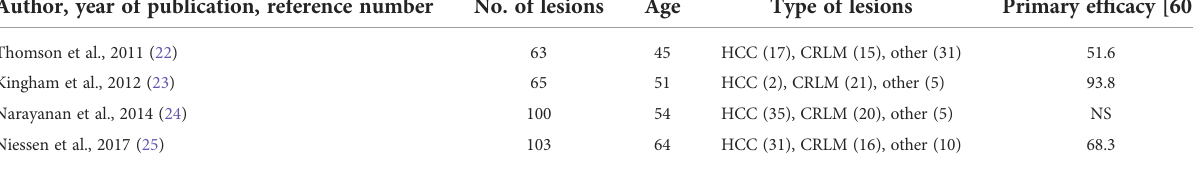
TABLE 2 Irreversible electroporation in